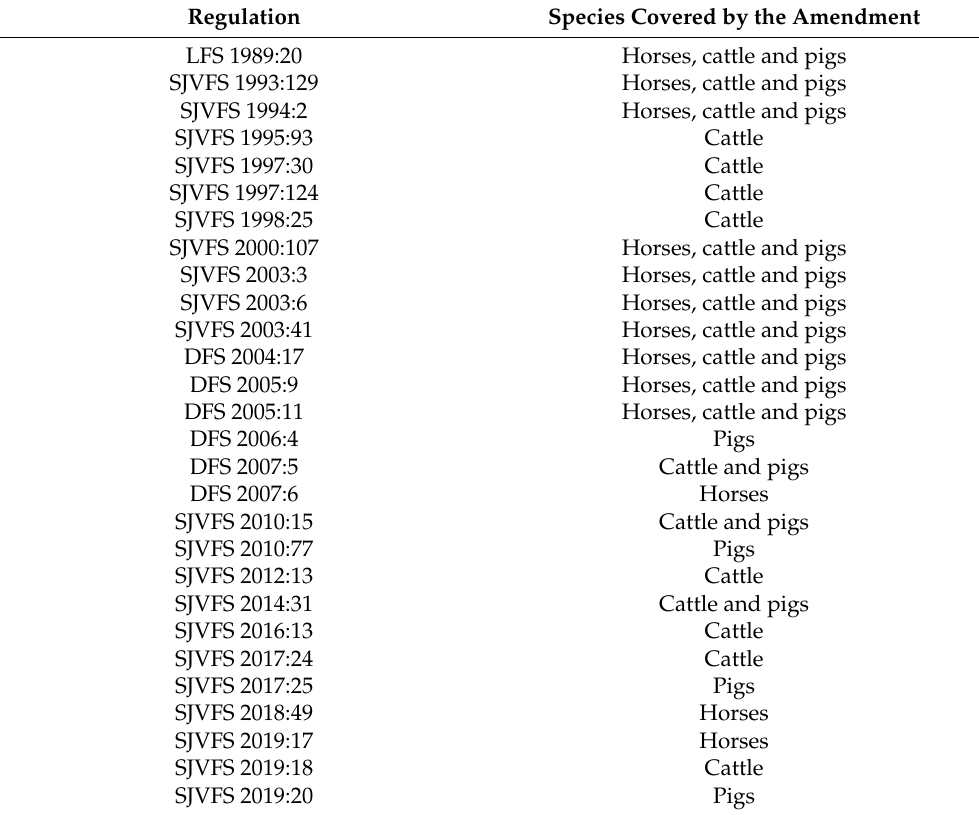
Table 1. Swedish animal welfare regulations on the housing and management of horses, cattle and pigs analysed in this study. ‘LFS’ represents regulations made by the National Board of Agriculture, ‘SJVFS’ represents regulations made by the Swedish Board of Agriculture and ‘DFS’ represents regulations made by the Swedish Animal Welfare